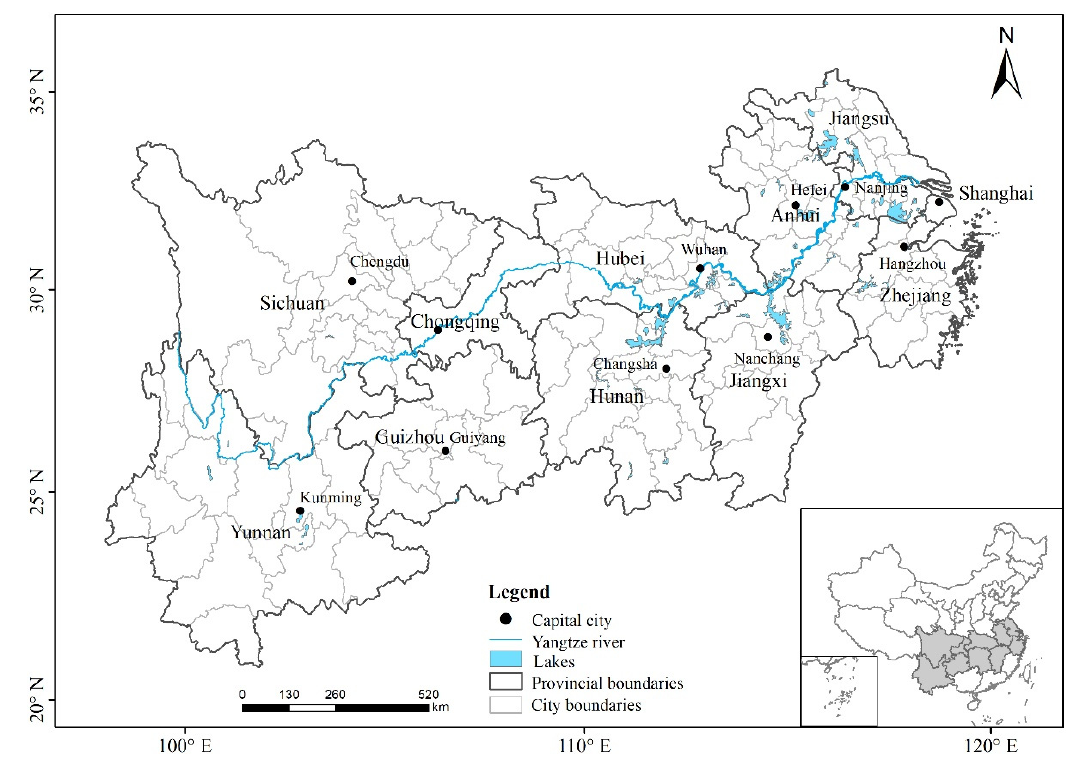
Figure 1. Administrative district map of the YREB.